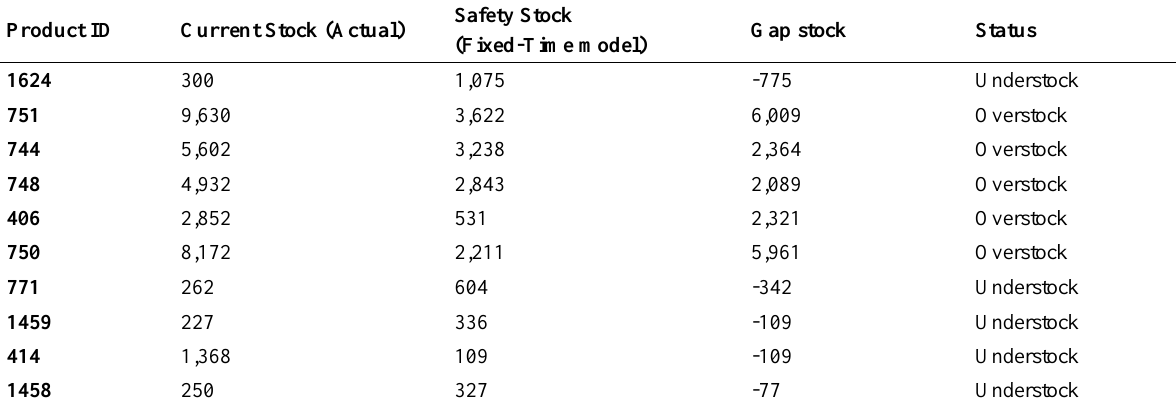
Table 4: Comparison between Actual Stock and Fixed-Time Model